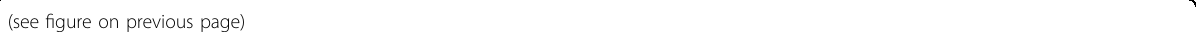
(see fi gure on previous page) Fig. 6 KDM6B demethylates H3K27me3 on the promoter of CCND1 and cooperates with smad2/3 to prompt the expression of CCND1. A A supervised hierarchical clustering of the genes differentially expressed between the C42B wild-type samples and the KDM6B depletion C42B samples is shown. B A correlation analysis between KDM6B and CCND1 using data from GEO:GSE46602 ( n = 50, p = 0.05, r = 0.28), GEO:GSE62872 ( n = 424, p = 0.001, r = 0.15), Dingtianlidi sequencing program ( n = 271, p < 0.001, r = 0.34) and the tissue microarray ( n = 176, p = 0.002, r = 0.23) was performed. C Representative images of the KDM6B and CCND1 immunohistochemistry results indicate a positive correlation between KDM6B and CCND1. D Comparisons of the CCND1 mRNA and protein expression levels among the siRNA-NC, siRNA-KDM6B, DMSO, and GSK-J4 treatments in the PC3 cell line were performed by PCR and western blot analyses. Error bars mean SD, n = 3 independent repeats. E A ChIP-PCR analysis demonstrates that the depletion and inhibition of KDM6B increases H3K27me3 on the CCND1 promoter in the PC3 cell line. Error bars mean SD, n = 3 independent repeats. F Immunoprecipitation-based mass spectrometry revealed the interaction between KDM6B and Smad2/3. G An immunoprecipitation analysis indicates that treatments with siRNA- KDM6B and GSK-J4 reduce the amount of interaction between KDM6B and Smad2/3. H Comparisons of the KDM6B and Smad2/3-binding levels to the CCND1 promoter among the siRNA-NC, siRNA- KDM6B , DMSO, and GSK-J4 treatments in the PC3 cell line were performed using a ChIP-PCR analysis. Error bars mean SD, n = 3 independent repeats (Note: DMSO, dimethylsulfoxide, ns: not signi fi cant, ** p < 0.01, *** p <